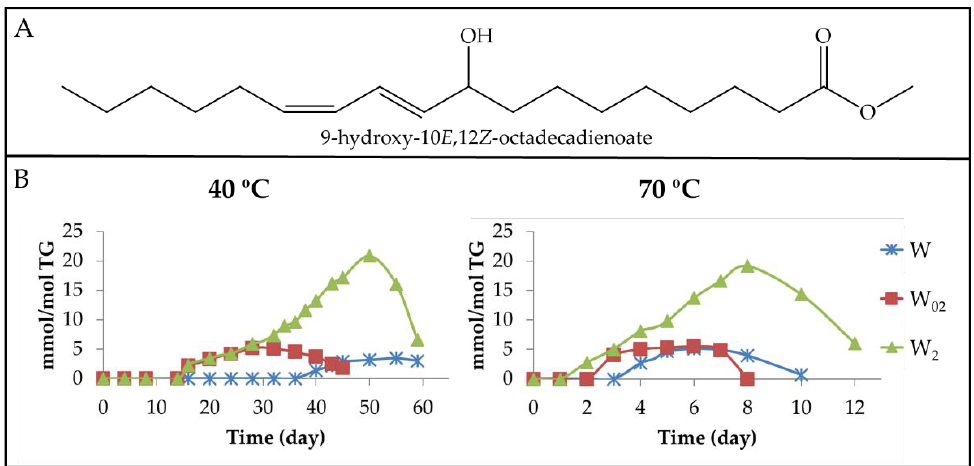
Figure 8. ( A ) Structure of 9-hydroxy-10 E ,12 Z -octadecadienoate as an example of mHO-c( Z , E )-dE. ( B ) Evolution of the concentration expressed as mmol/mol TG, of mHO-c( Z , E )-dEs in walnut oil with different enrichment levels of αT (W, W 02 and W 2 ), submitted to either 40 °C or 70 °C up to advanced stages of the oxidation process.